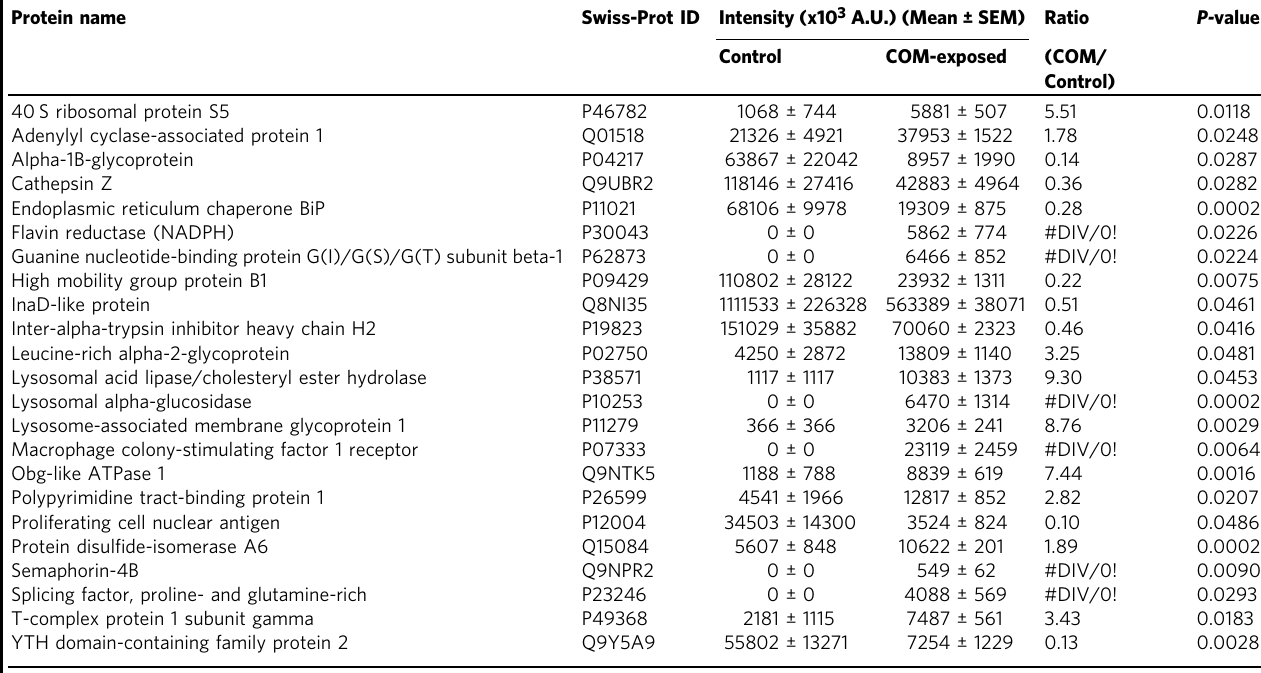
Table 1 Summary of signi fi cantly altered proteins in COM-exposed macrophage secretome identi fi ed by nanoLC-ESI-LTQ- Orbitrap